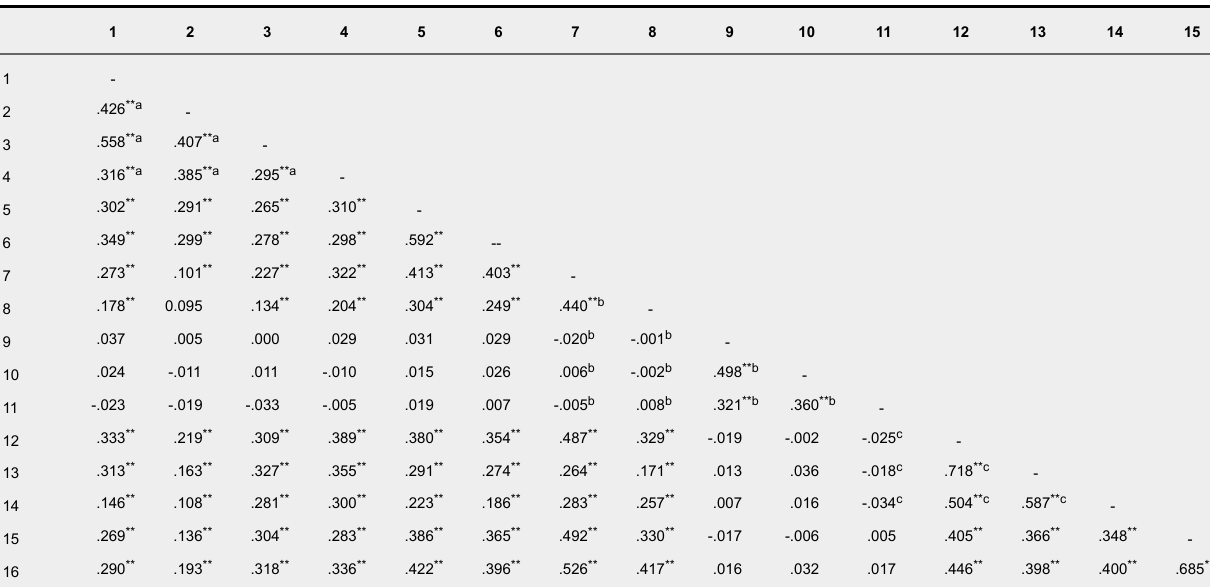
Relationships Between MATAL Tasks After Recalculating